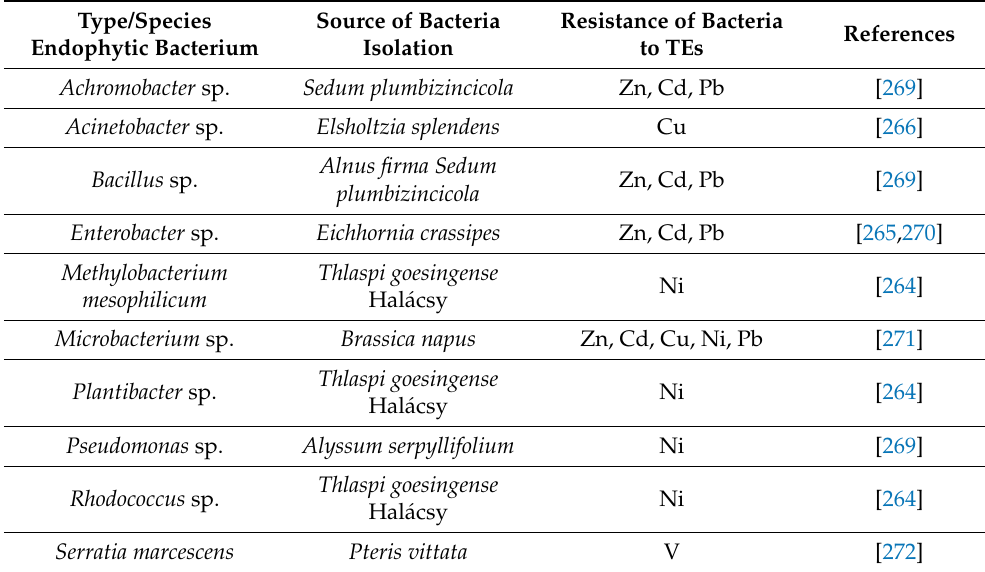
Table 6. Resistance of endophytic bacteria growing in heavy metal contaminated